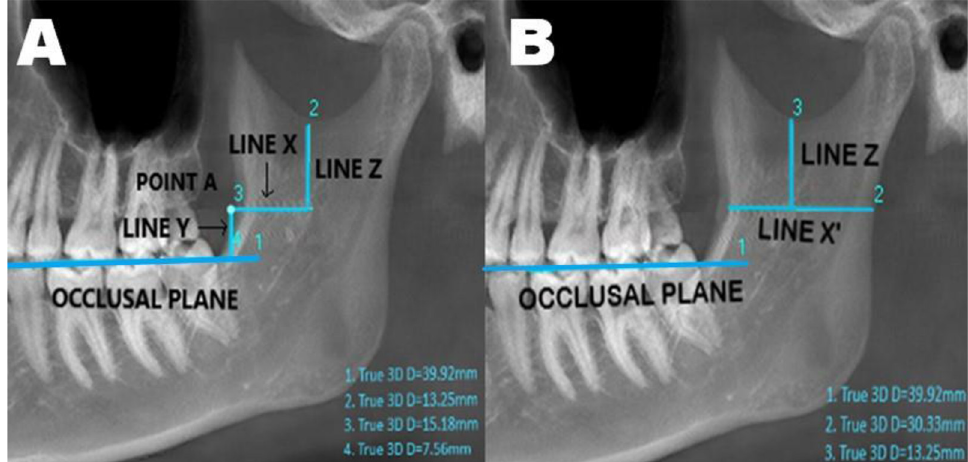
Fig. 1. Diagrammatic representationof measurements on ramal surface of mandible(A) Showing Line X, Y, Z and Point A, (B) Showing Line X ’ and Line Z.